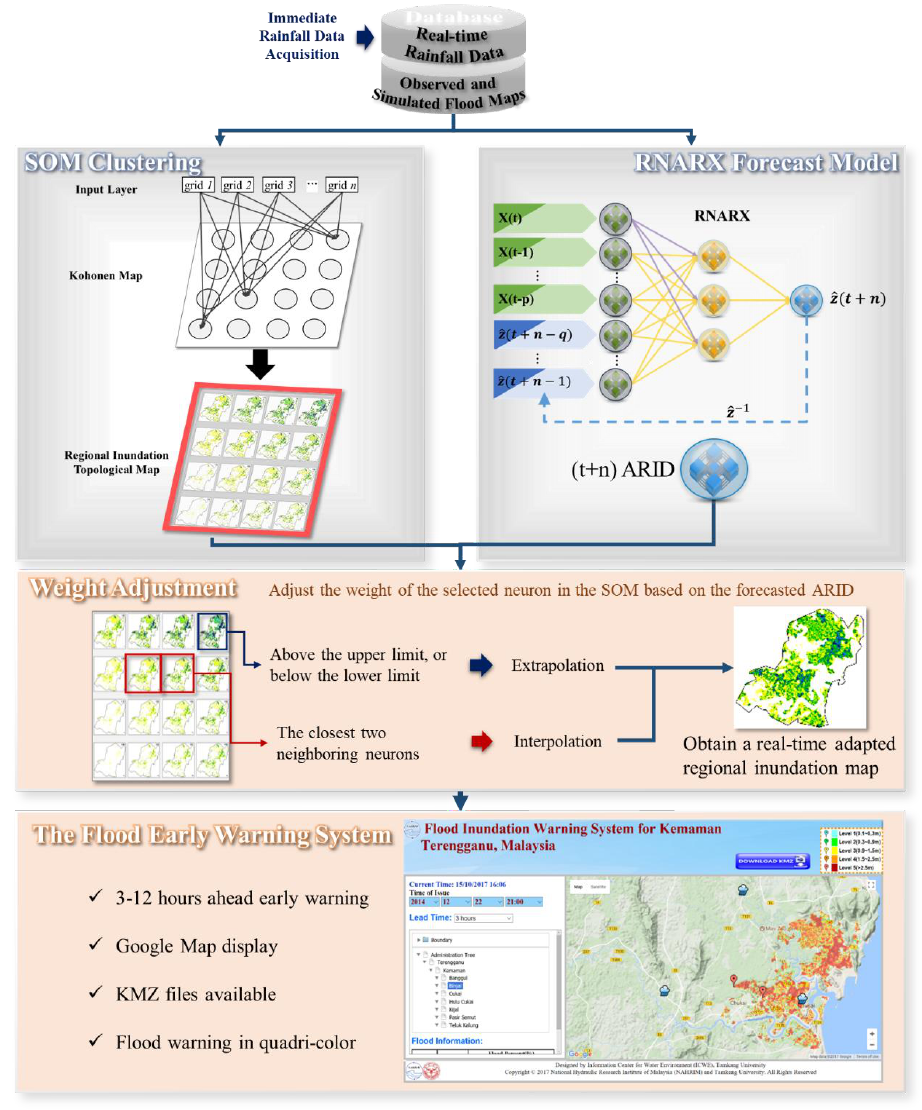
Figure 6. Methodology of the hybrid SOM – RNARX model.